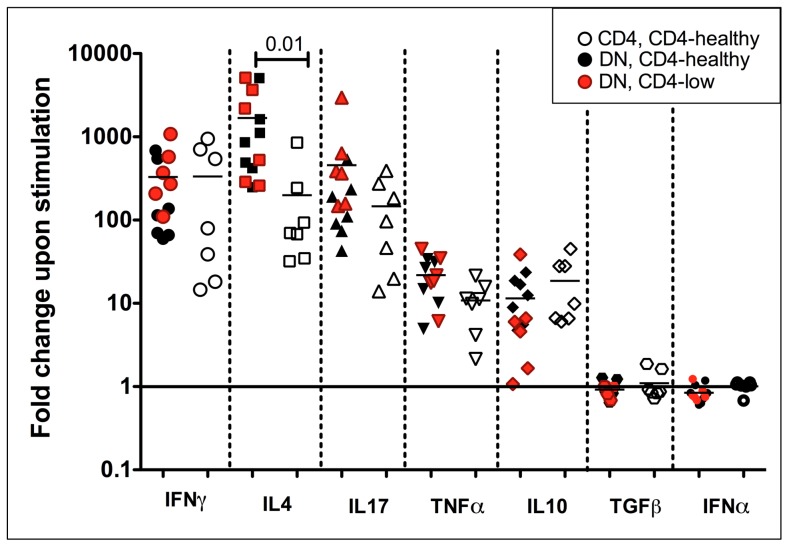
Quantitative real time PCR analysis of TCR stimulated DN and CD4 T cells from SIV infected mangabeys.Real time PCR analysis of purified DN and CD4 T cells isolated from SIV+ mangabeys demonstrates upregulation of IFNγ, IL4, IL17, TNFα and IL10 upon TCR-stimulation. Cytokine expression of DN T cells from SIV+ CD4-healthy mangabeys (black symbols), SIV+ CD4-low mangabeys (red symbols) and CD4 T cells from SIV+ CD4-healthy mangabeys (open symbols) are depicted. Cytokine profiles of DN T cells are maintained irrespective of CD4 T cell loss. Log scale fold change is shown on the Y-axis with no change in mRNA expression due to stimulation indicated by a baseline (1 fold). Symbols represent IFNγ (large circle), IL4 (square), IL17 (triangle), TNFα (inverted triangle), IL10 (diamond), TGFβ (hexagon) and IFNα (small circle).